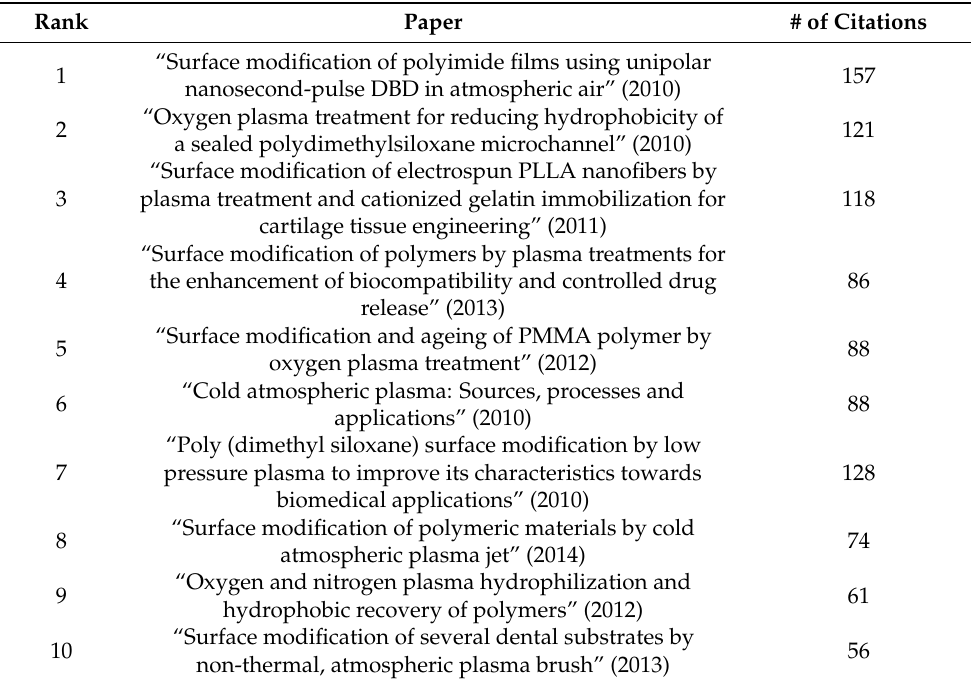
Table 2. Top 10 publications with impacts in other fields related to plasma surface treatment. (papers listed in the table refer to